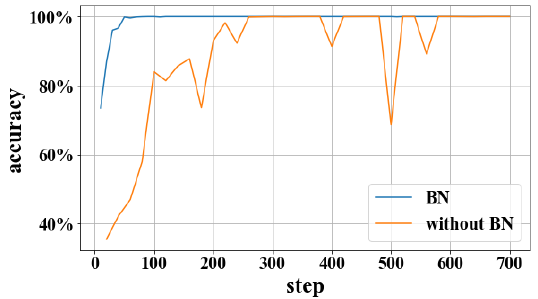
Figure 5. The accuracy of without BN and BN. Sensors 2019 , 19 , x